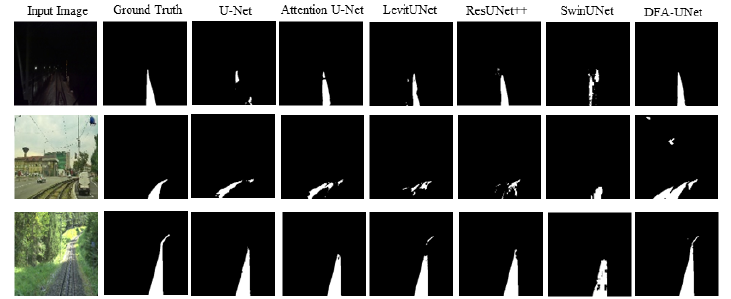
Figure 6. Qualitative comparison results between DFA-Net and other models on rail segmentation datasets.